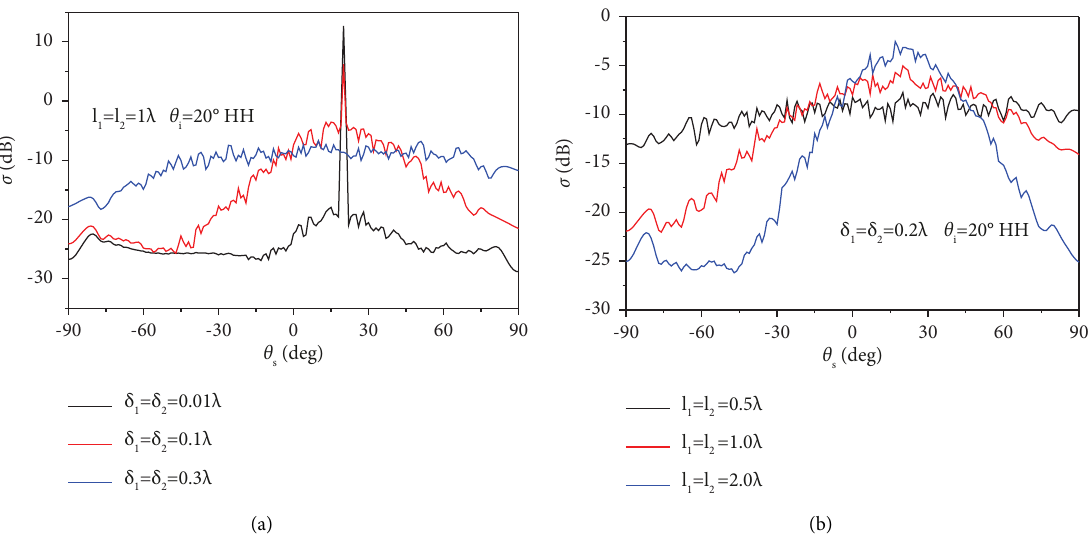
Figure 5: Angular distribution of NRCS for diferent roughness, (a) diferent δ , and (b) diferent l